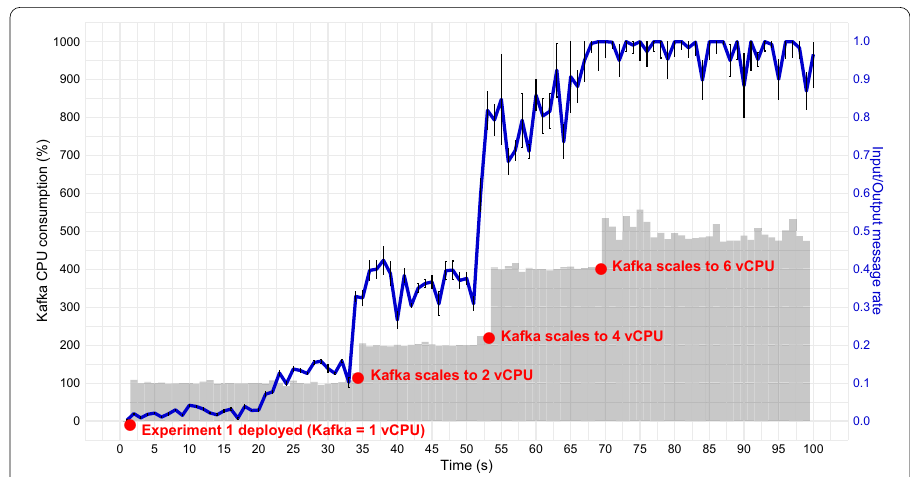
Fig. 9 I/O message rate evolution in an experiment with vertical scaling mechanisms